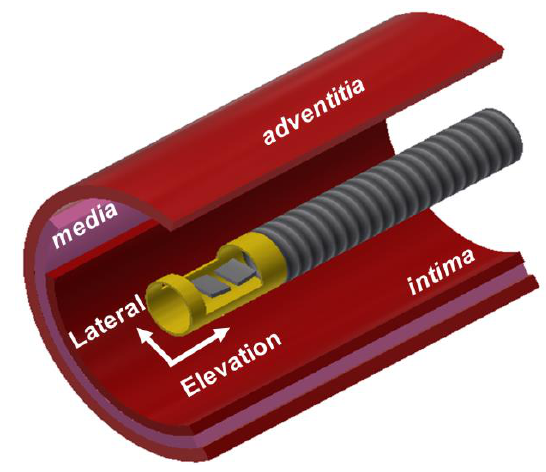
Figure 1. Conceptual illustration of the proposed dual-element oblong-shaped-focused transducer for intravascular ultrasound tissue imaging using the third harmonic.